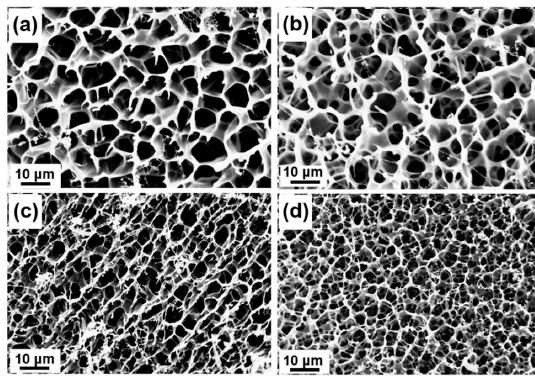
Figure 4. SEM images of homogeneous peptide-based bis-acrylate/AAc hydrogels before biodegradation: ( a ) Gel-1; ( b ) Gel-2; ( c ) Gel-3; ( d ) Gel-4. With the increasing of peptide-based content, the pore size of the hydrogels decreases. bis-acrylate contents, the pore size of the hydrogels would